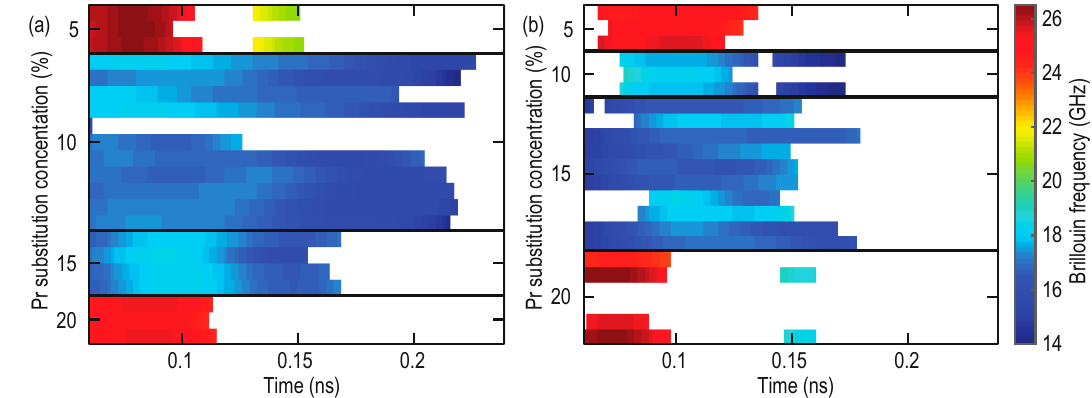
Figure 3. Brillouin frequency (BF) images as a function of the time delay between pump and probe pulses and of the Pr substitution concentration from TDBS measurements conducted ( a ) at normal incidence (0°) and ( b ) at oblique incidence (52°).